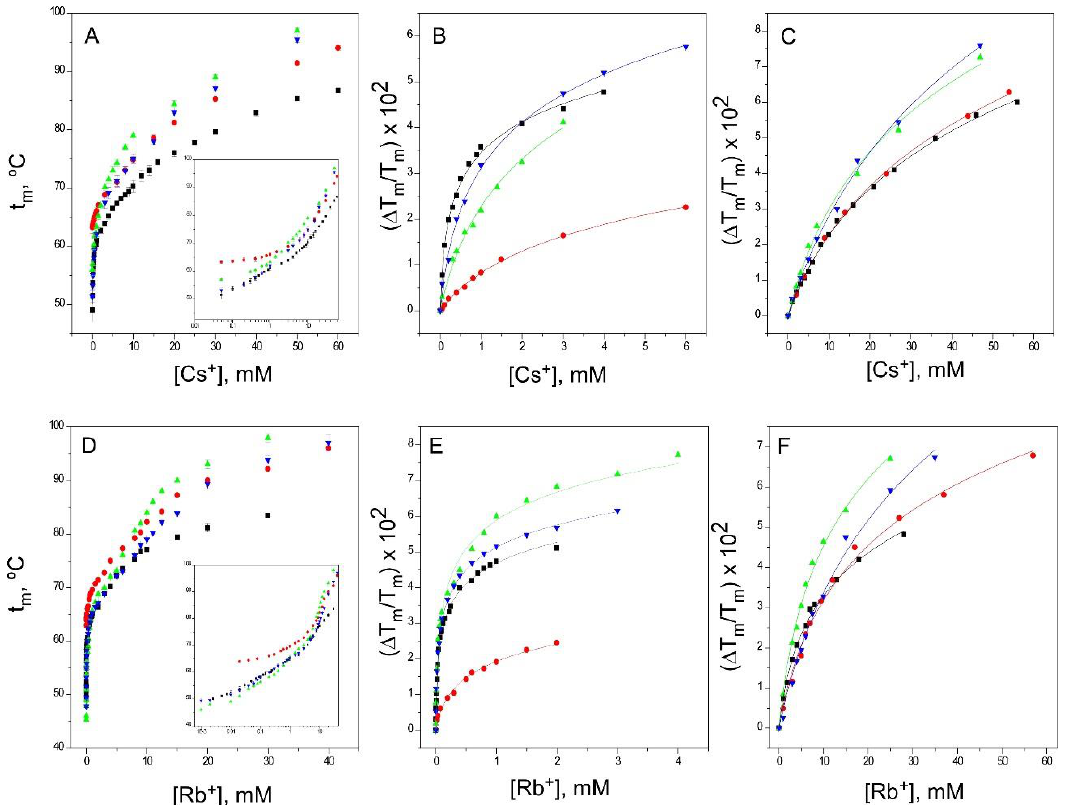
Figure 7. Binding of Cs + and Rb + to KcsA. The changes in the apparent t m with the concentration of Cs + and Rb + (Panels A and D , respectively) allows the detection of two sets of thermodynamically different binding sites, as illustrated in the insets to Panels A and D. The results are the average ( n = 3) t m (in Celsius) ± SD. Panels B and E show the fitting of the experimental data to Equation (1) for the first sets of binding sites for the two cations (low concentration range), whereas Panels C and F show the fits for the second set of binding sites (high concentration range). The symbols and colors are the same as in Figure 2. The apparent K D values calculated for these experiments are included in Table I.